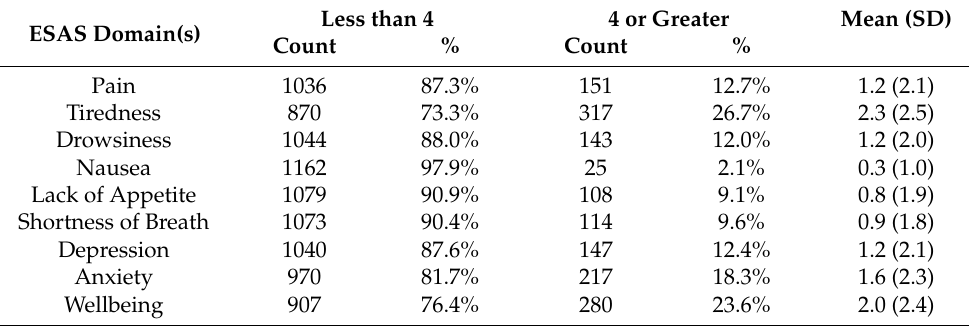
Table 3. ESAS domain score categorized and mean score (n =